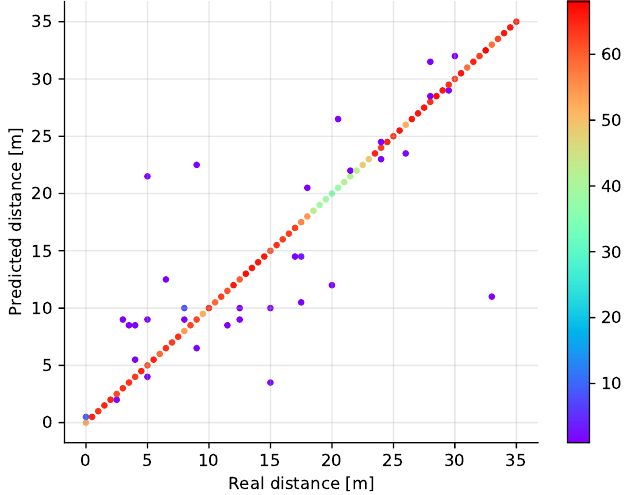
Figure 14. Scatter plot showing the predicted versus the real distances in a single dimension using the Multi Layer Perceptron with the two hidden layers containing 640 and 320